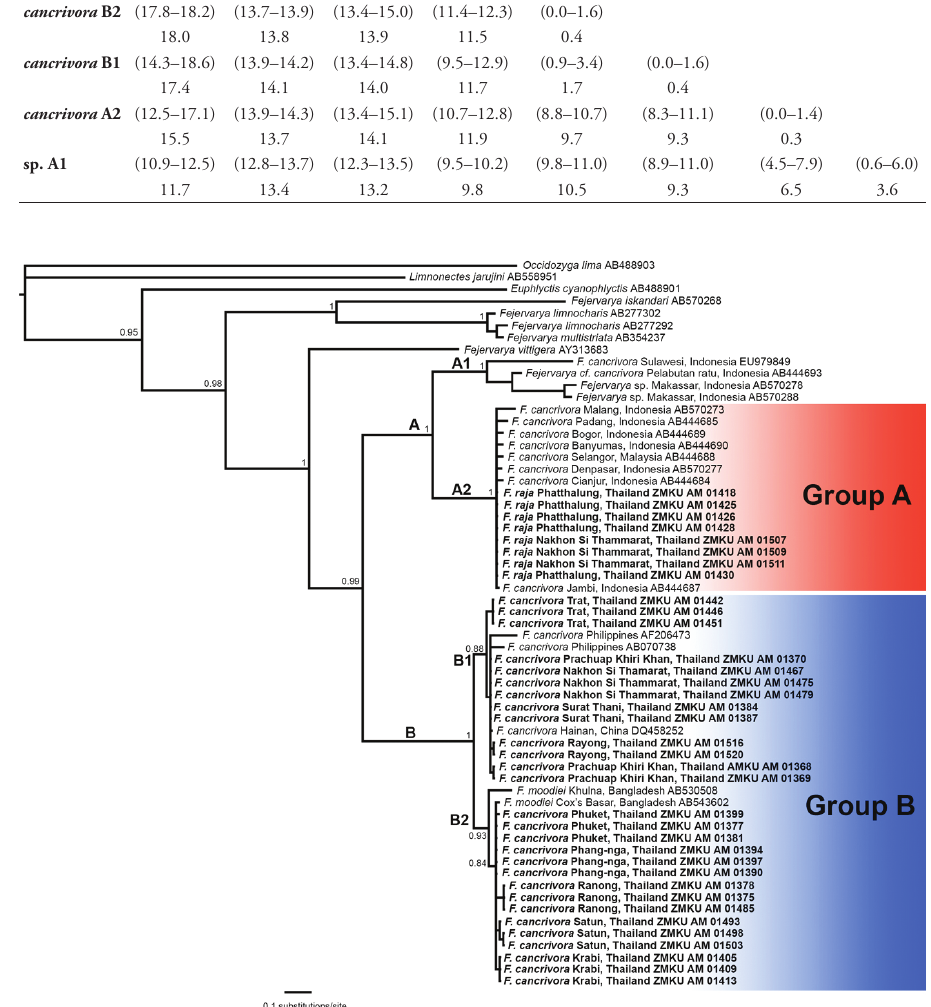
Figure 2. Bayesian consensus phylogram of the mitochondrial16S rRNA gene of Fejervarya cancrivora and the closely related species, F. moodiei and F. raja . Numbers at nodes represent Bayesian posterior probability support values. Clade and subclade names are presented next to branches and group names are presented to the right of terminal taxa.